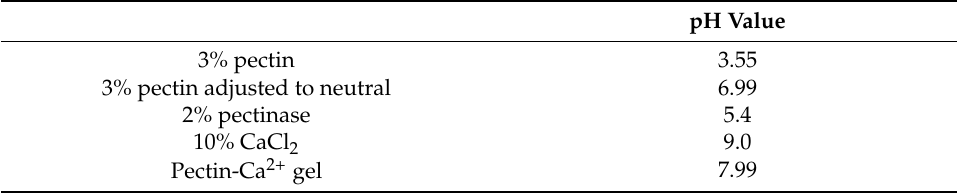
Table 2. Different pH of reactants used to prepare and enzymatically hydrolyze PC–DOX.